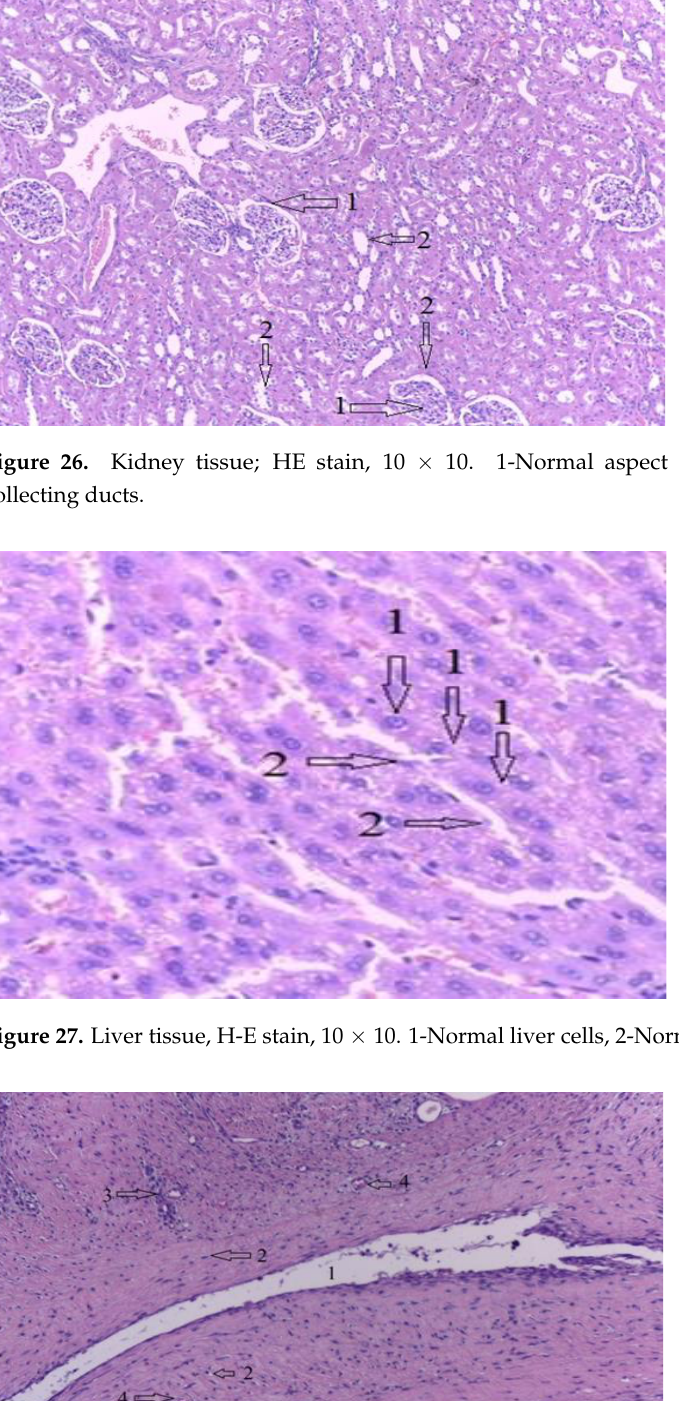
Figure 28. Synovial membrane, H-E stain, 10 × 10. 1-Hydrogen bubbles, 2-Normal synoviocytes, 3-Limited areas of inflammatory tissue, 4-Normal blood vessels.